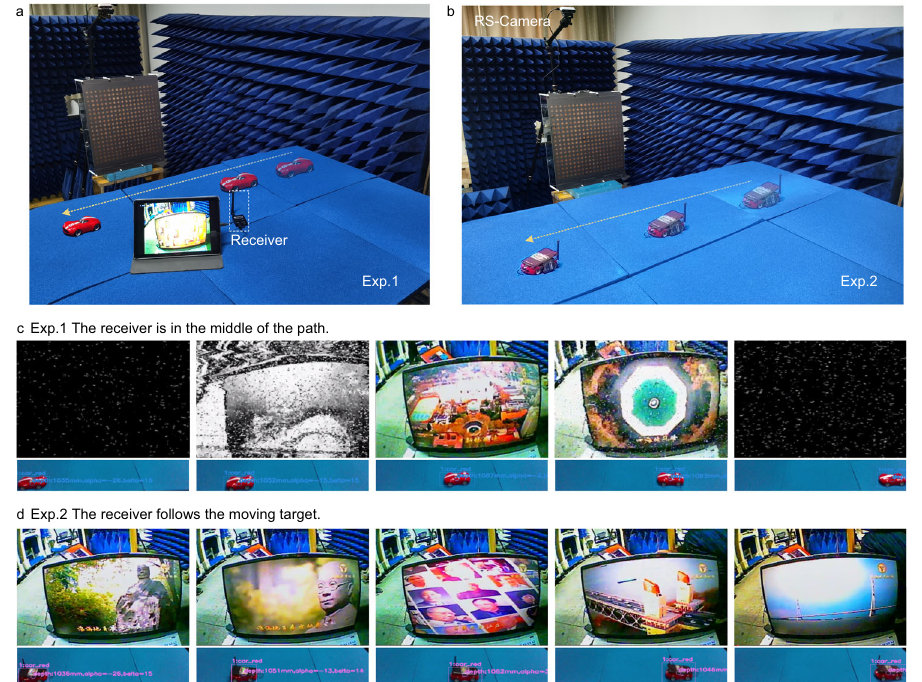
Fig.7|Experimentsofwirelesscommunications.a , b Experimentscenarioswhen the receiver is in the middle of the path ( a ) and when the receiver follows the moving target ( b ). c , d Experimental results of received video frames at fi ve